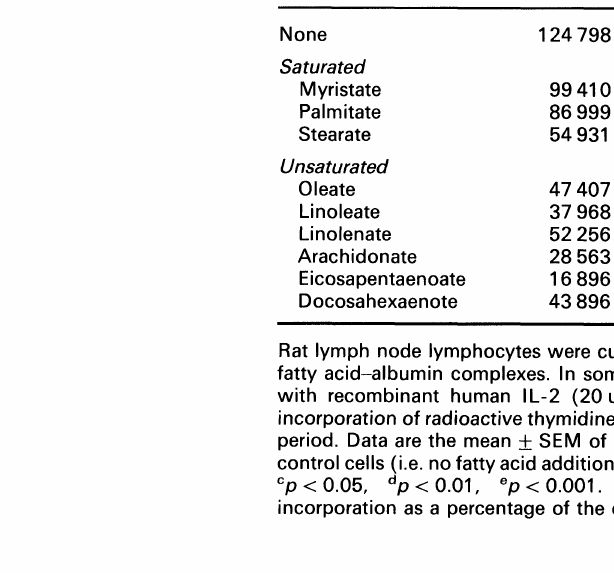
Table 2. Effect of fatty acids on Con A-stimulated lymphocyte proliferation in the presence and absence of added L-2 Fatty acid Thymidine incorporation (dpm/well) No addition Exogenous L-2 None 124798_+5415(100) Saturated Myristate